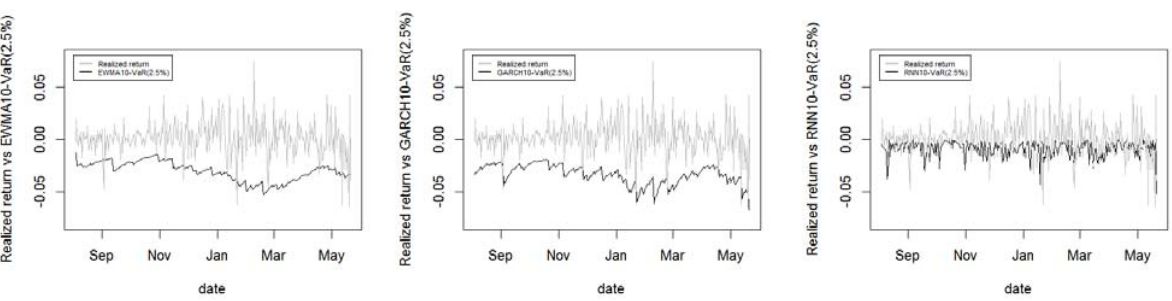
Figure A9. Out of sample realized return vs. 10 days ahead VaR (2.5%) of EWMA, GARCH and RNN model. Figure 9 . Out of sample realized return vs 10 days ahead VaR(2.5%) of EWMA, GARCH and RNN model Figure 9 . Out of sample realized return vs 10 days ahead VaR(2.5%) of EWMA, GARCH and RNN model Figure 9 . Out of sample realized return vs 10 days ahead VaR(2.5%) of EWMA, GARCH and RNN model